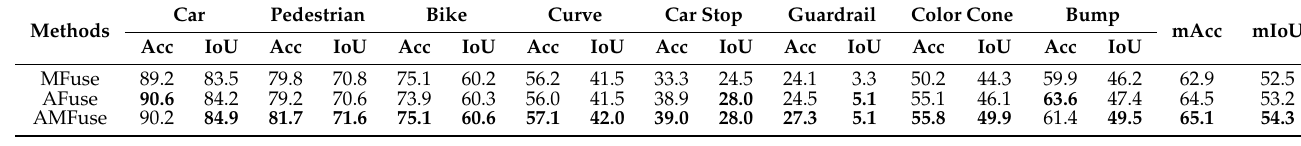
Table 7. The comparisons of MFuse, AFuse and AMFuse modules based on ResNet-50 backbone (%).